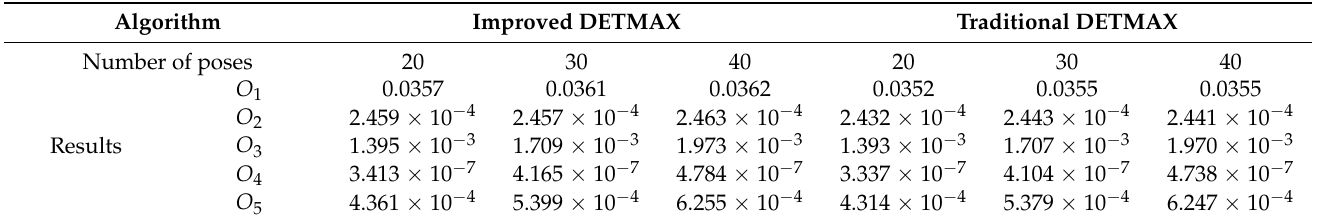
Performance comparison between improved DETMAX algorithm and traditional DETMAX